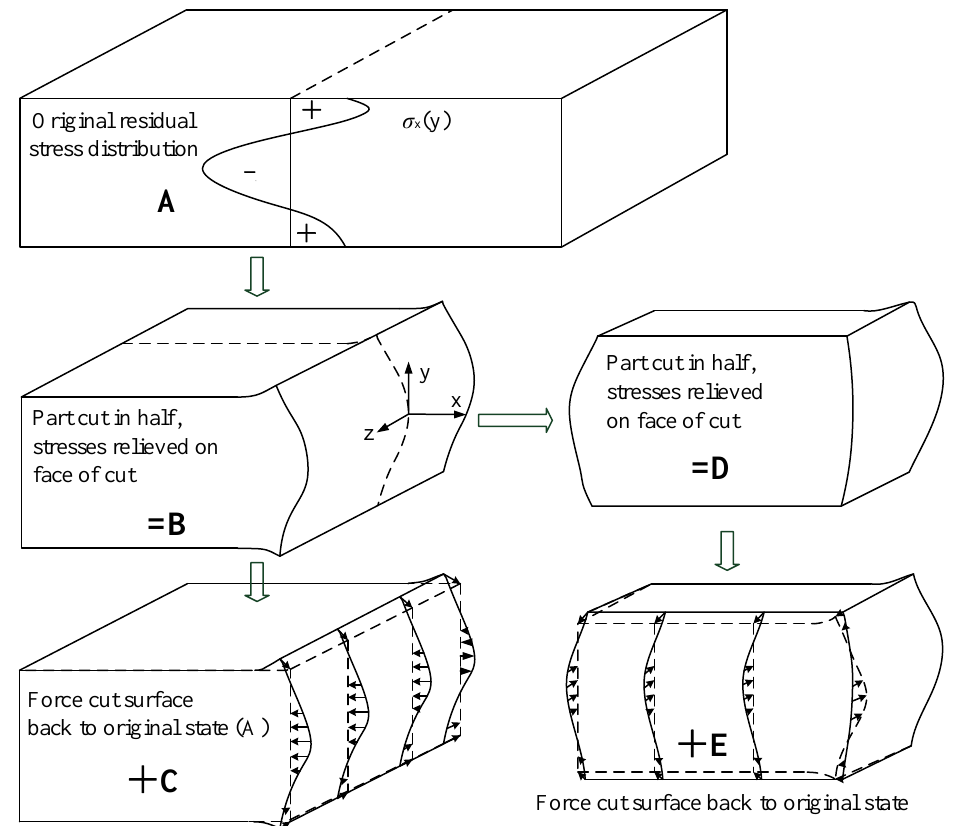
Figure 3. Contour method superposition principle for traditional contour method ( A – C ) and multiple cuts ( D – E ). The two-cut plane defines x = 0 and z = 0 [28].